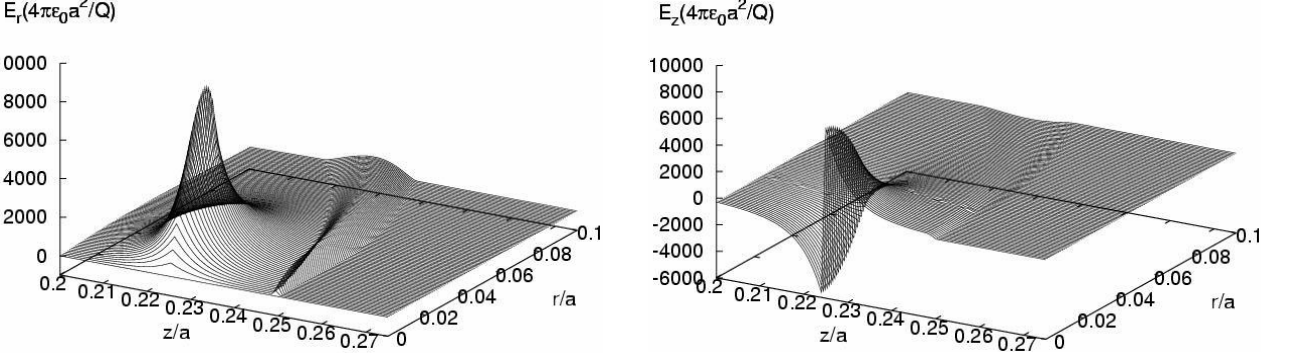
(cid:3) 4 (cid:7)" a 2 (cid:4) =Q vs r=a and z=a for t (cid:2) 0 : 25 a=c . FIG. 4. Plot of E z (cid:3) 4 (cid:7)" 0 a 2 (cid:4) =Q vs r=a and z=a for t (cid:2) 0 : 25 a=c . FIG. 2. Plot of E r 0